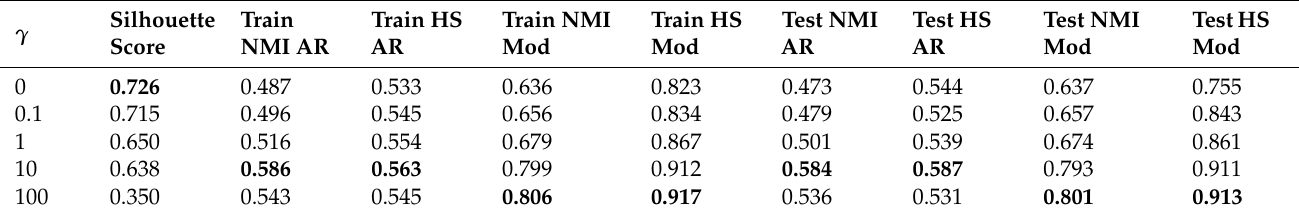
Table 2. Performance of the proposed model with respect to the value of γ , where K = 25 clusters. The remaining loss-function weights are fixed to the following values: α = 0.1 and β = 1. The best result in each column is printed in